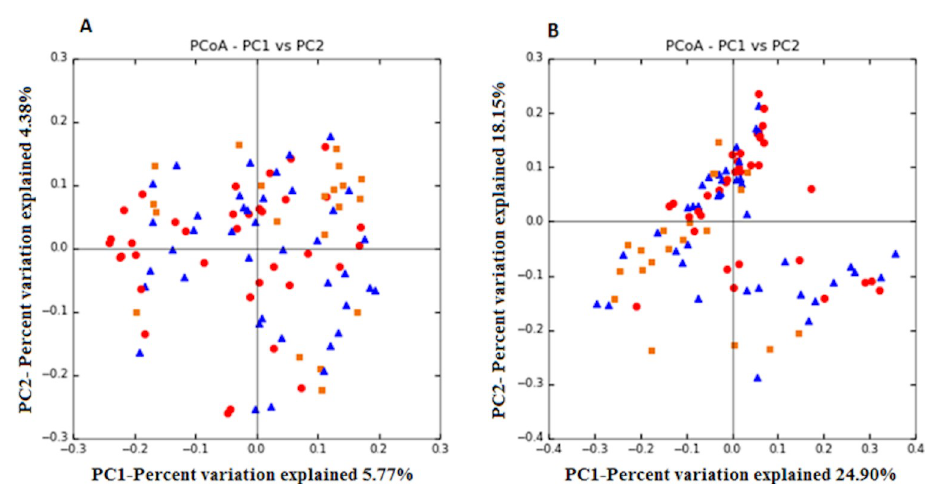
Fig 2. Clustering of fecal bacterial communities according to the different study groups by principal coordinate analysis (PCoA) using unweighted (A) and weighted (B) UniFrac distances. Each point corresponds to a community coded according to the patient group and control group. The percentage of variation explained by the plotted principal coordinates is indicated on the axes. Orange square: control group; blue triangle: pre-eradication group; red dot: post-eradication group.